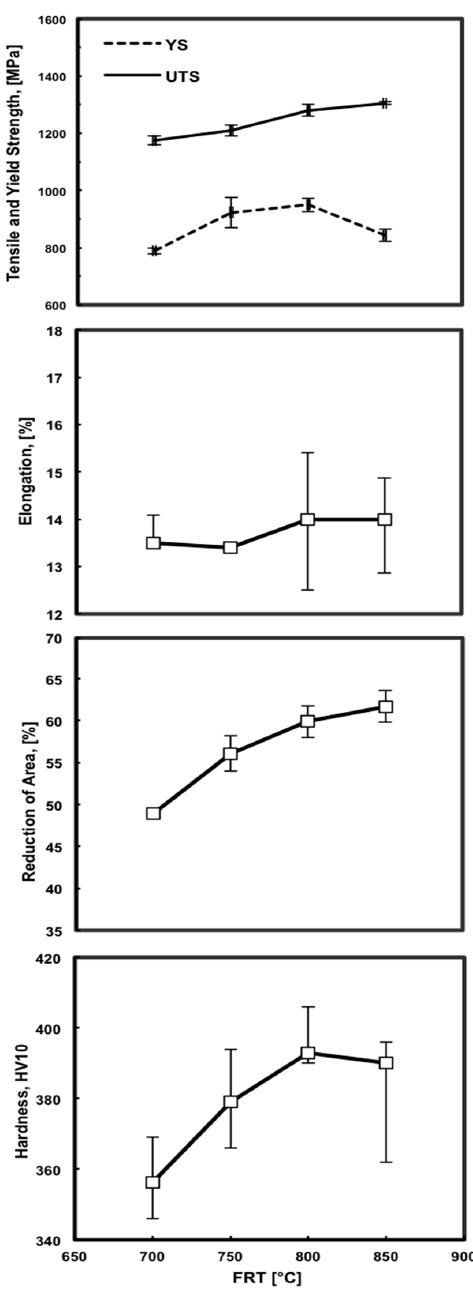
Figure 6. Variation in yield strength (YS), ultimate tensile strength (UTS), elongation, reduction of area and hardness with the finish rolling temperature.